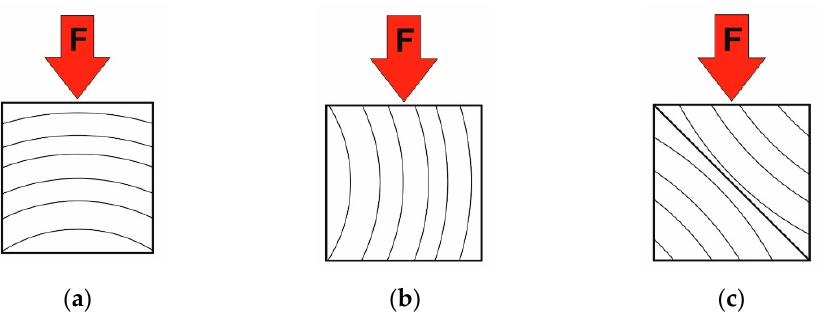
Figure 6. Direction of the bending force relative to the annual rings: ( a )—solid board, radially loaded; ( b )—solid board, tangentially loaded; ( c )—bonded board.